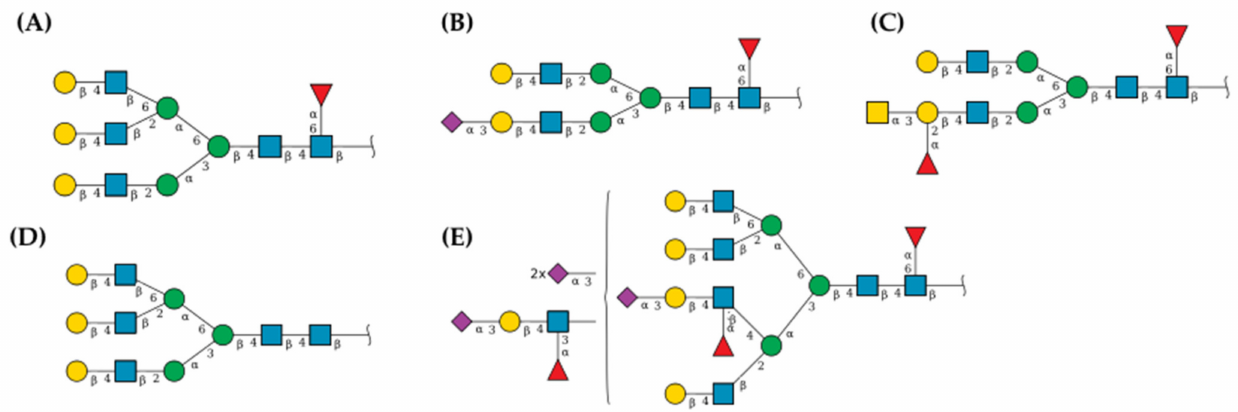
Figure 10. EGFR-related glycans with a high possibility of interaction with rTBL-1. N-glycans are presented according to the symbol nomenclature for glycans [46]. Docking data are not